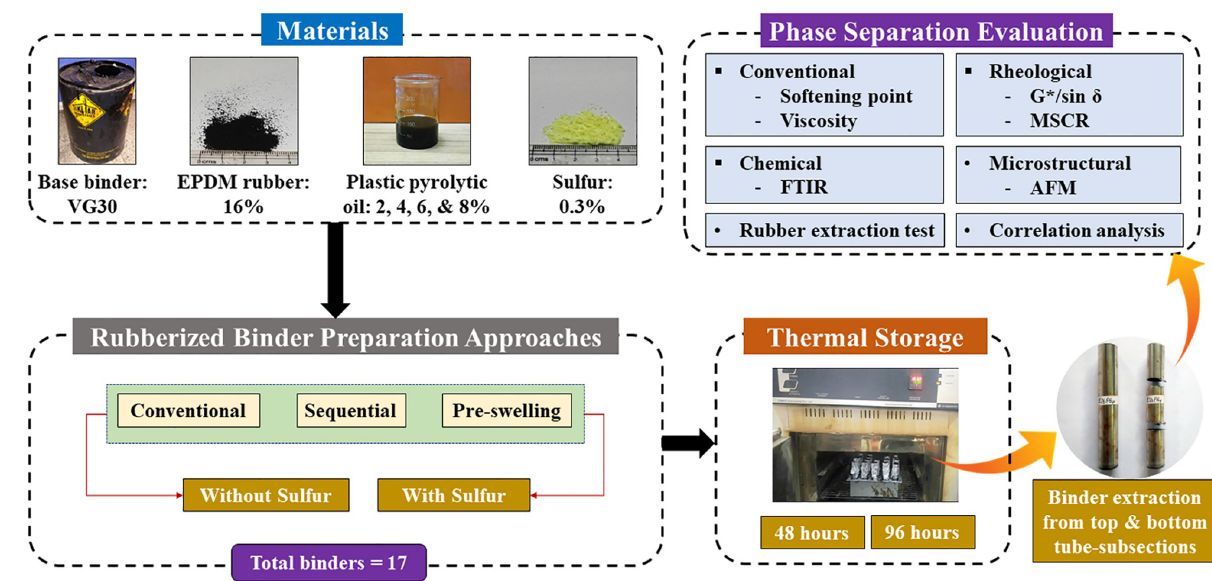
Fig 1. Outline of the research protocol adopted for this